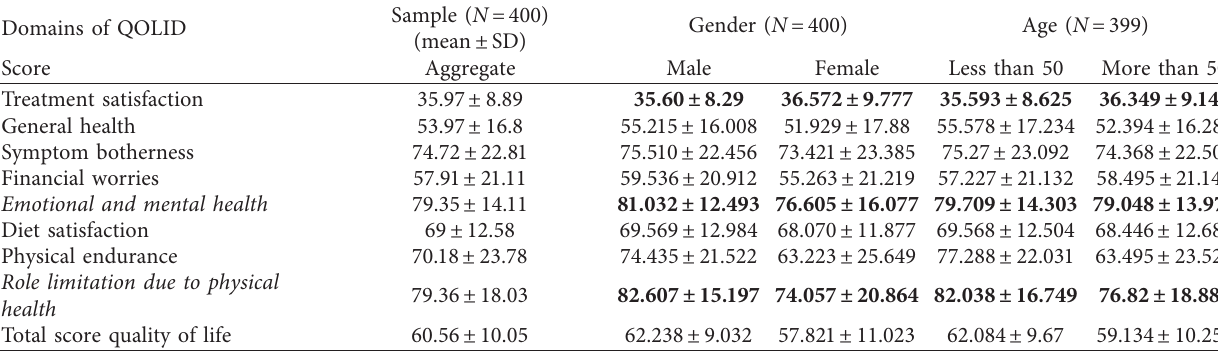
Table 1: QOLIID scores: total score and domainwise score presented agewise and